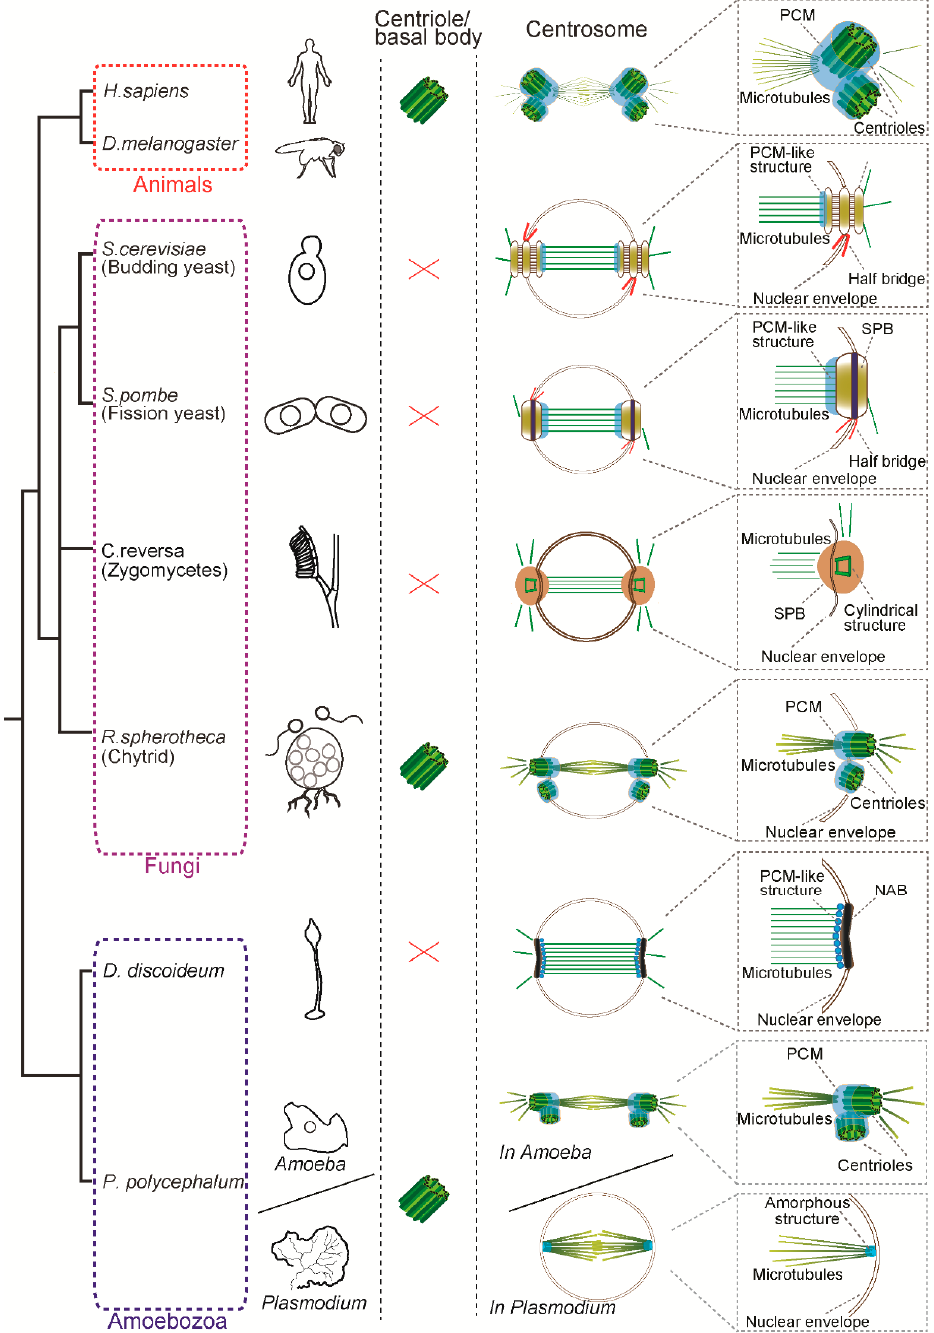
Figure 1. Structure of the centrosome in mitosis in animals, fungi and amoebozoa. Animals and basal fungi (chytrids) have a centriole/basal body and a canonical centrosome composed of a pair of centrioles surrounded by pericentriolar matrix (PCM), which anchors and nucleates microtubules. In contrast, the yeasts such as S. cerevisiae and S. pombe have a centriole-less centrosome called the spindle pole body (SPB). Another fungus C. reversa has a distinct SPB containing a cylindrical structure reminiscent of a centriole. In the Amoebozoa, while D. discoideum has a centriole-less nucleus-associated body (NAB), P. polycephalum has two modes of centrosomes: animal-like centriolar centrosome in the amoeba phase and an amorphous structure devoid of centriole at the pole in the plasmodium phase. Note that size of the centrosomes and spindle are not depicted to scale in this figure.